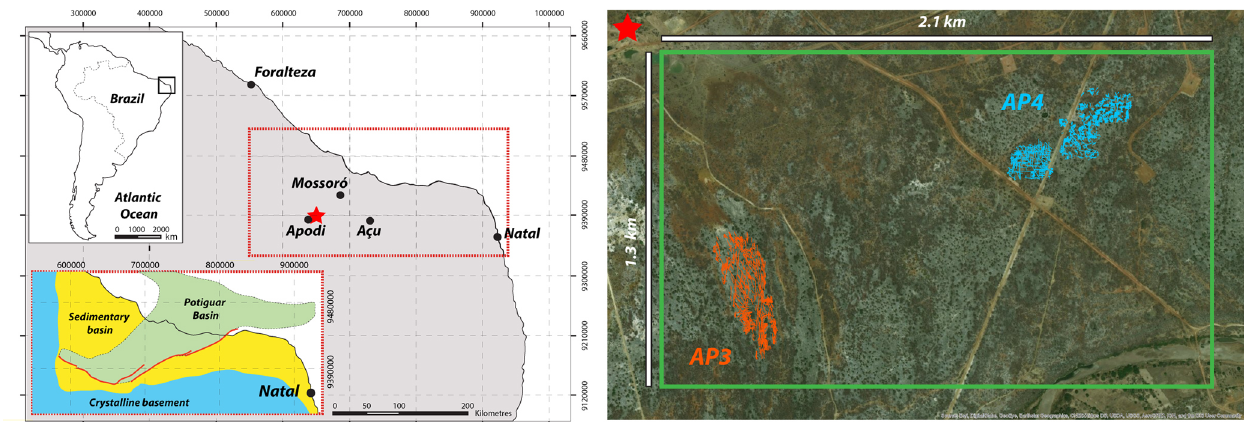
2017). From the Miocene to the Quaternary the onshore